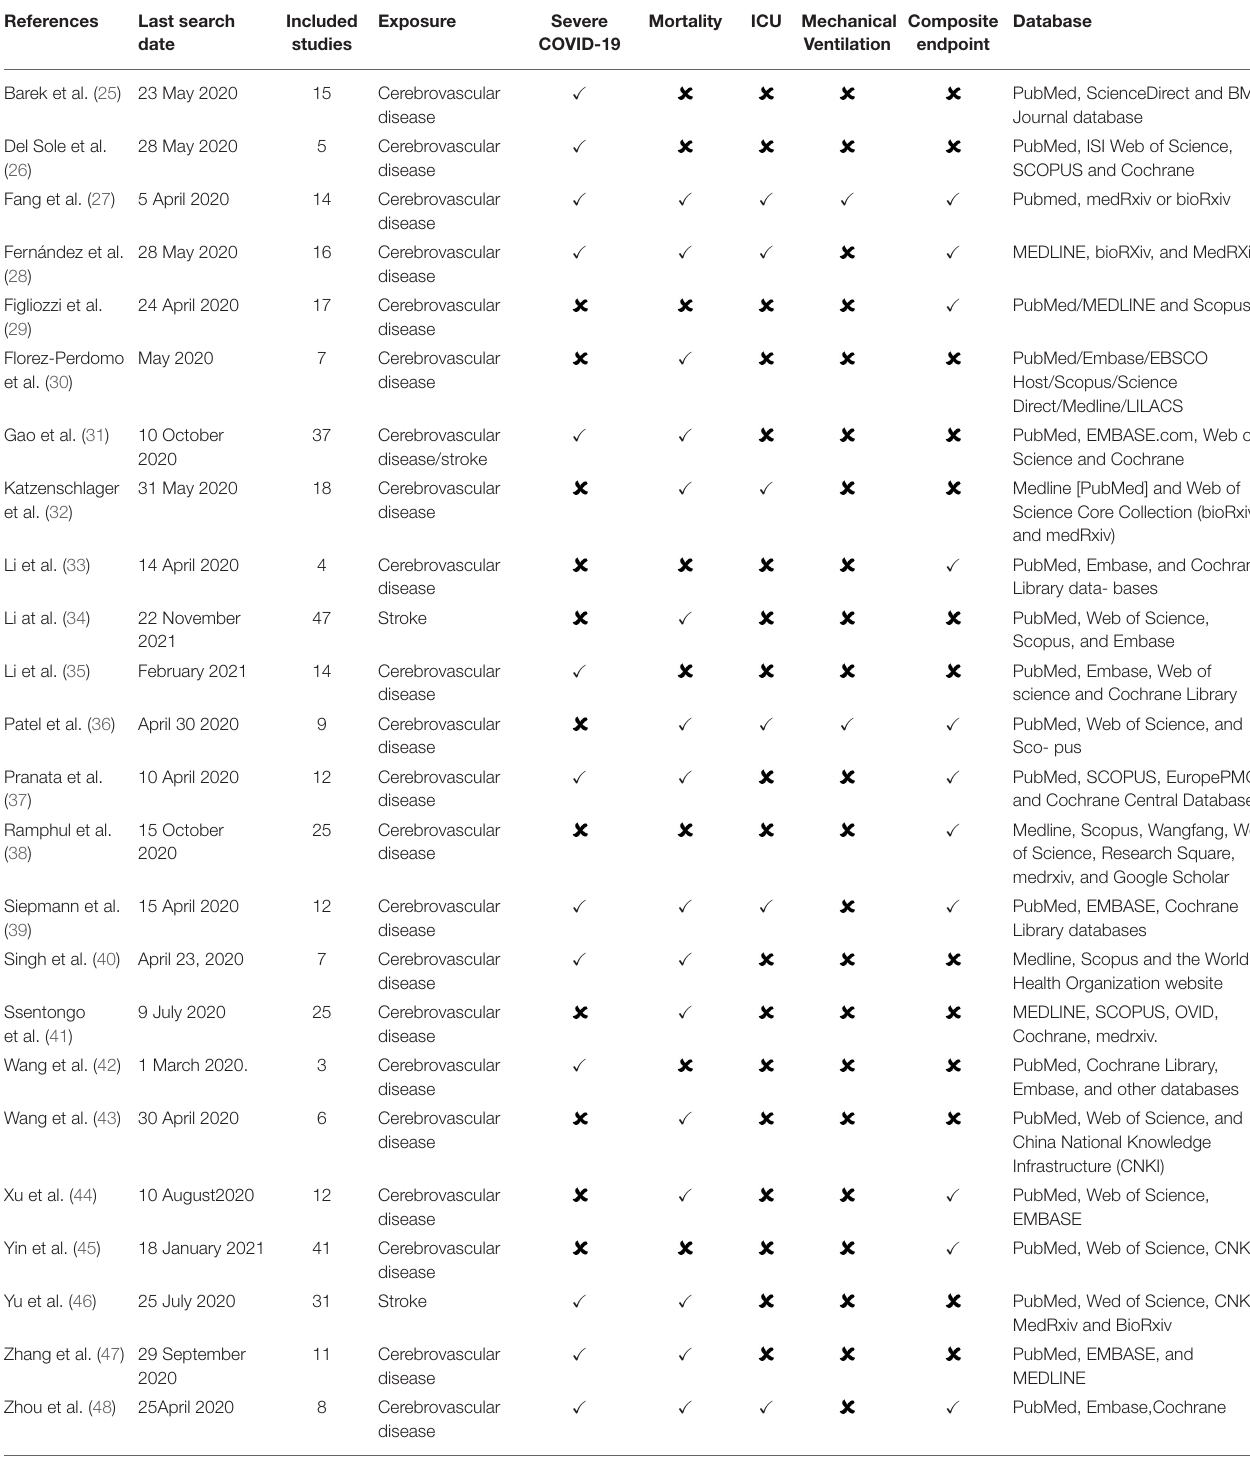
TABLE 4 | Characteristics of included systematic review and